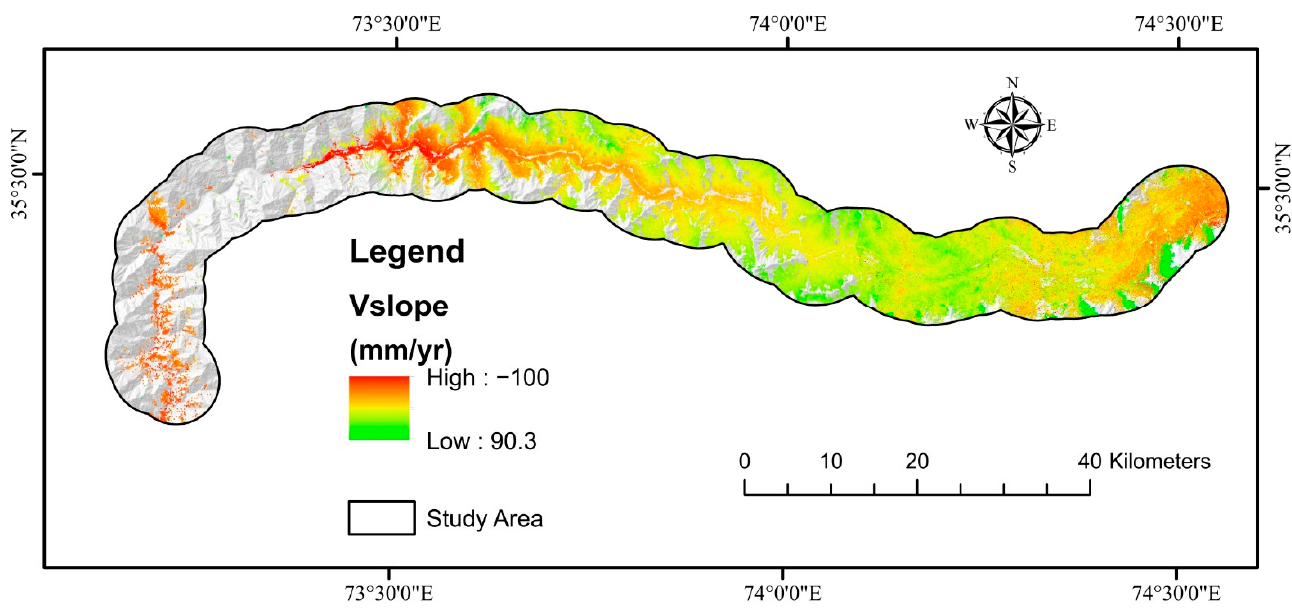
Figure 13. Showing the deformation velocity along slope direction for both ascending and descending paths using PS-InSAR.